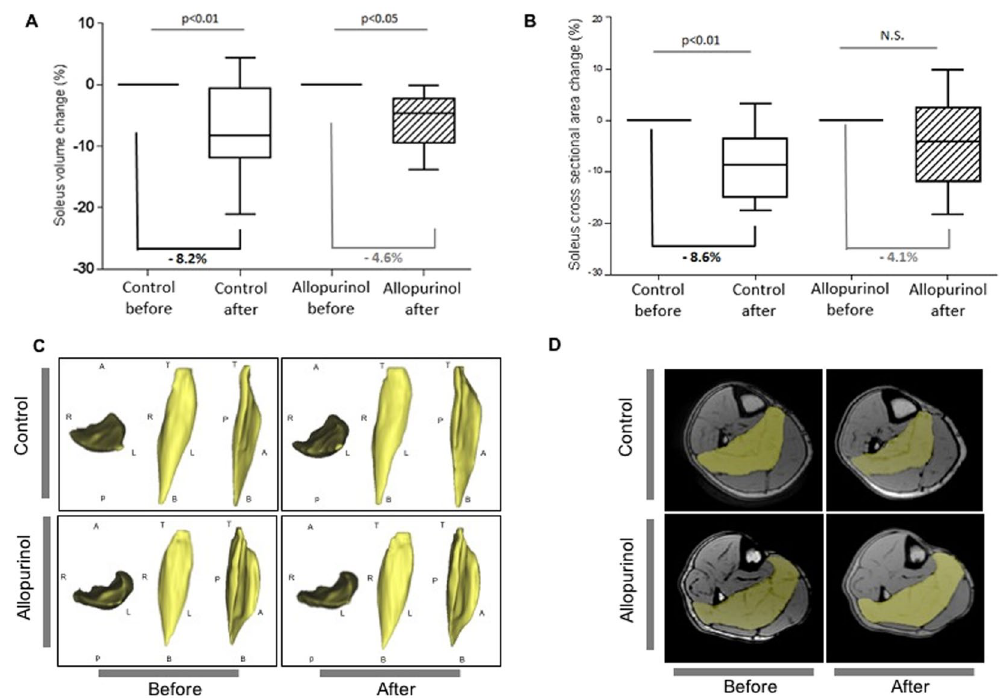
Figure 4. Allopurinol-treated ankle sprain patients are partially protected against unloading-induced skeletal muscle atrophy. ( A) Quantification of the changes in soleus muscle volume during lower leg immobilization with a posterior ankle splint. (B) Quantification of the changes in soleus muscle CSA during lower leg immobilization with a posterior ankle splint. (C) Representative volume images after analysis and segmentation of the soleus muscle in control and allopurinol-treated subjects. R = right, L = left, A = anterior, P = posterior, T = top, B = bottom. (D ) Representative magnetic resonance images of control and allopurinol-treated subjects. The soleus muscle is shown in